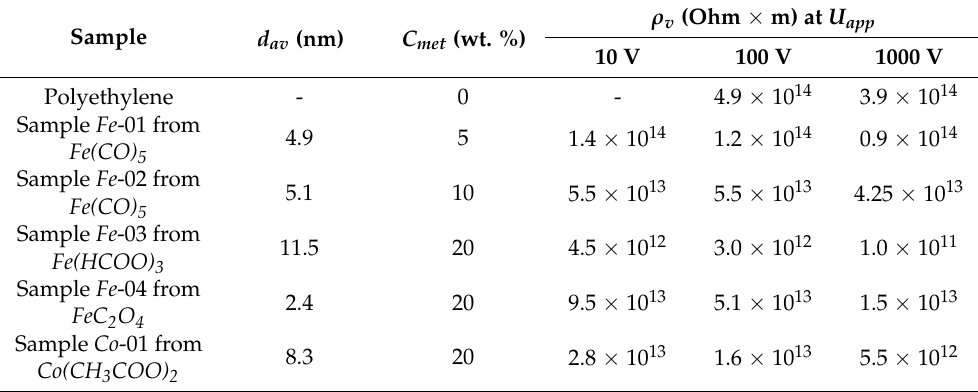
Table 1. Results of measurement of ρ v composite materials based on Fe - and Co -containing nanoparticles.